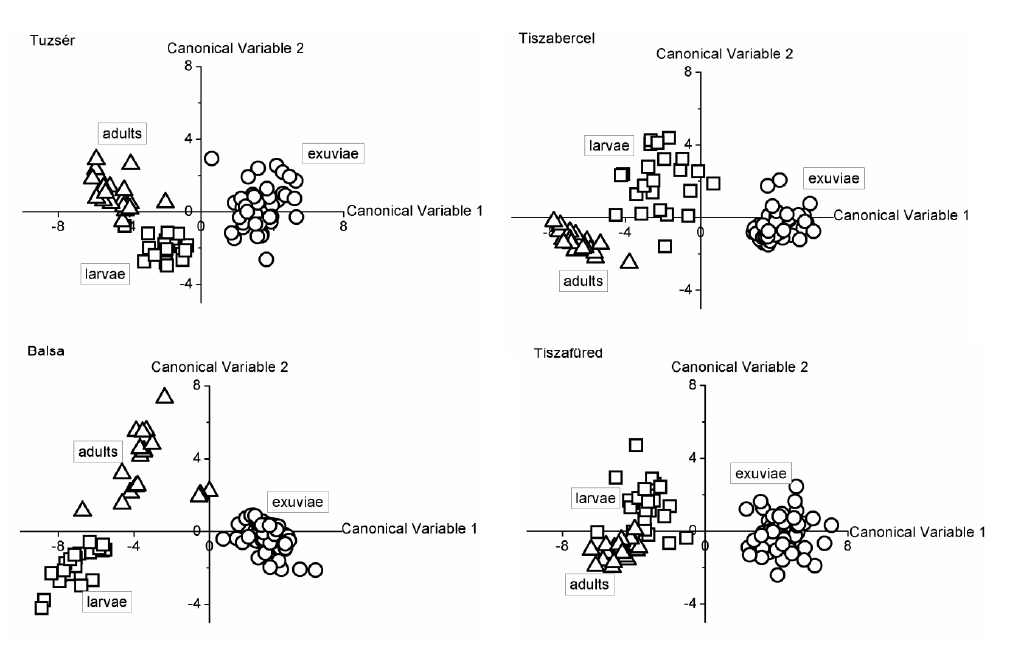
Figure 1. Canonical discriminant plots of trace element contents (microgramme-scale element per individual) in the developmental stages of